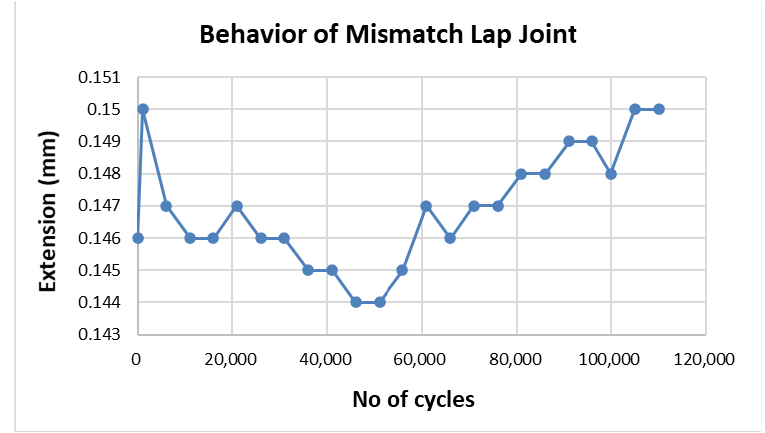
Figure 8. Fatigue crack growth in double strap match lap joint (specimen 3, sample 2).